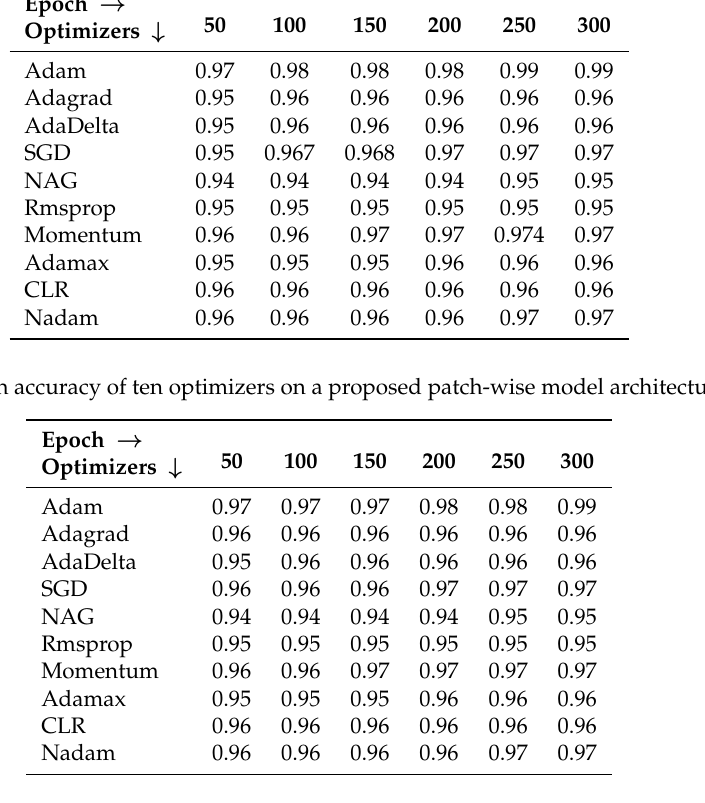
Table 5. The training accuracy of ten optimizers on a proposed patch-wise model architecture of CNN. Epoch →